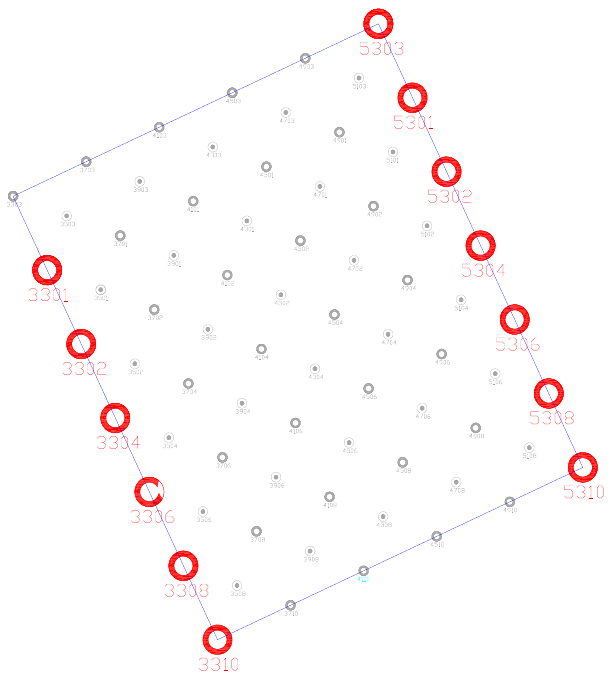
Figure 5. Schematic diagram of injection well for flow adjustment in target mining area.